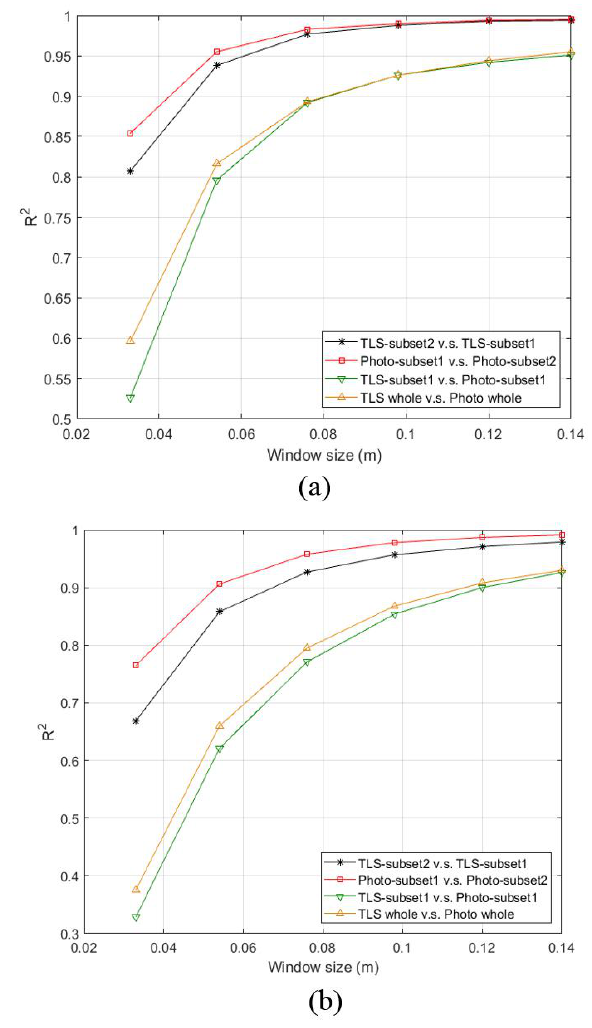
Figure 6. The coefficient of determination R2 for the correlation between the surface roughness maps derived using SfM and TLS, respectively: (a) RMSH, (b) standard deviation of